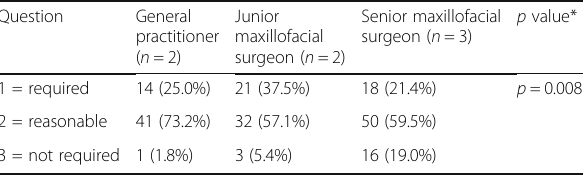
Table 2 Results of the question “ An additional sFOV-CBCT of the clinical area of interest is …”